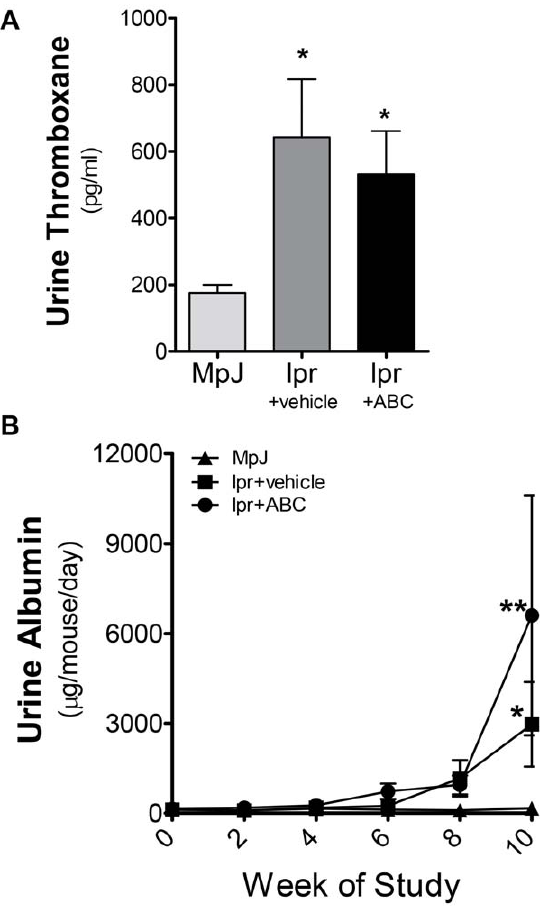
Figure 5. ABC294640 does not prevent increases in urine thromboxane or albumin levels. After 10 weeks of ABC294640 or vehicle administration, 24-hour urine samples were collected from MRL/ MpJ and MRL/lpr mice. A ) Urine thromboxane and B ) urine albumin levels were measured by ELISA. Data represent mean 6 SEM, n $ 10; *p , 0.05 treated vs. MPJ.